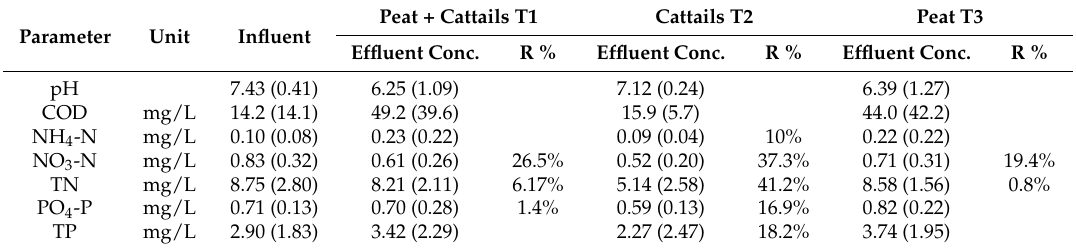
Table 2. Mean effluent pollutant concentrations and removal efficiencies in each treatment wetland reactors for start-up period 1 .